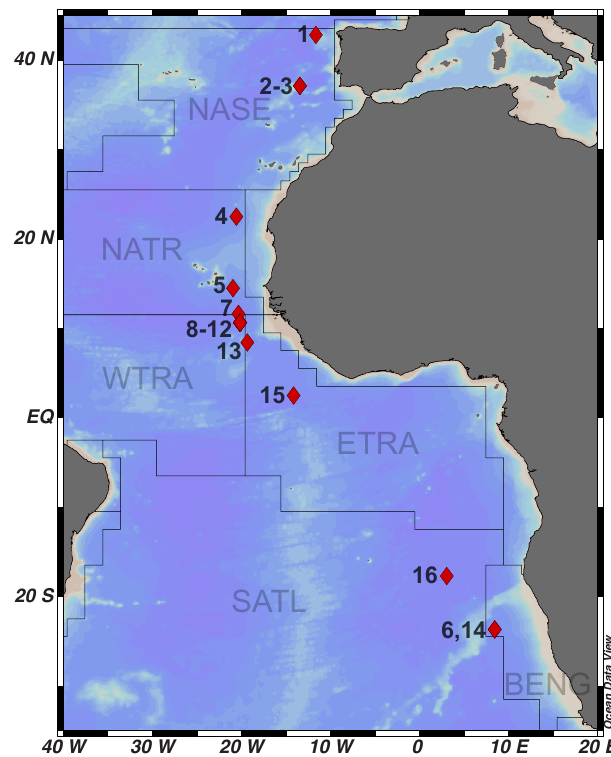
Fig. 1. Collection locations of 16 water samples analysed in this study. Figure created with Ocean Data View (Schlitzer, 2011) with shape file overlay from VLIZ